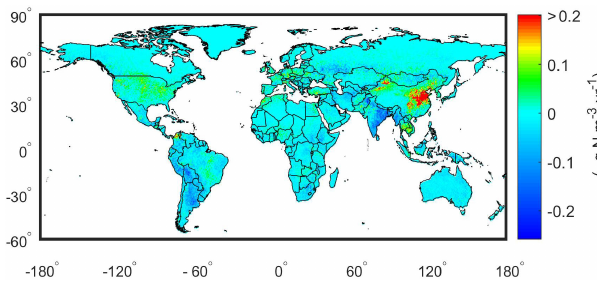
Figure 9. Trends of IASI-derived surface NH 3 concentrations be- tween 2008 and 2016. A linear regression was performed to calcu- late the trends. The significance value ( p ) and R 2 for the trends can be found in Fig.